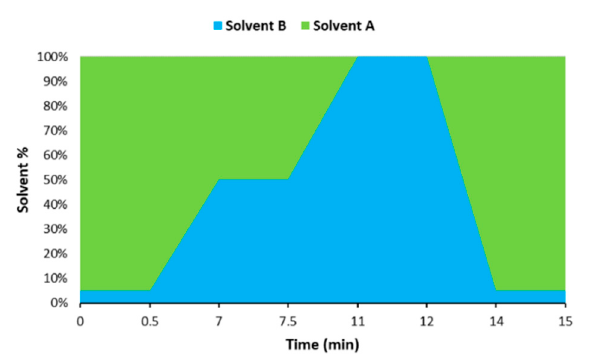
Figure 1. Graphical representation of the gradient used for the chromatographic analysis. The flow rate was 0.250 mL/min, and the injection volume 2 µL. Mass spectrometry (MS) acquisition was achieved with electrospray ionization interface (ESI) operating in positive ion mode.